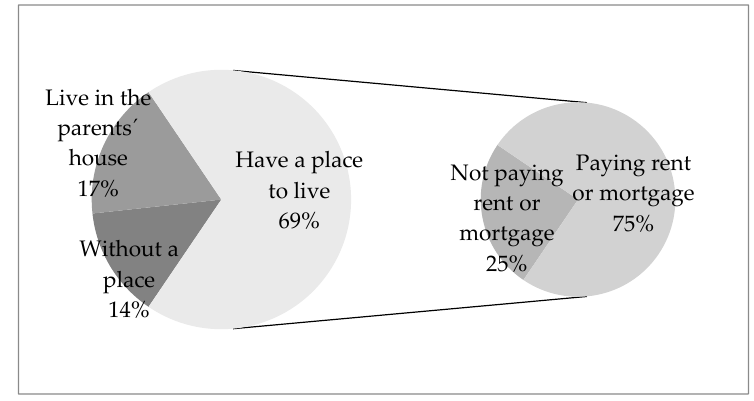
Figure 2. Chart showing housing before moving to an eco-community. Source: Prepared by the authors.